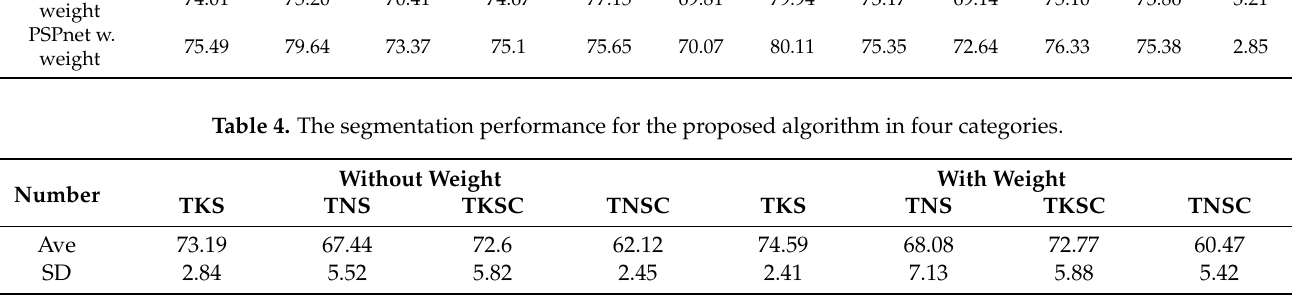
Table 4. The segmentation performance for the proposed algorithm in four categories.